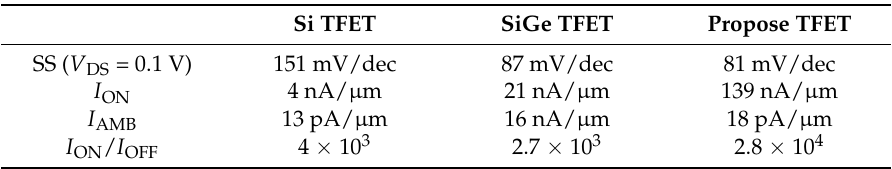
Table 1. Summary of extracted parameters.